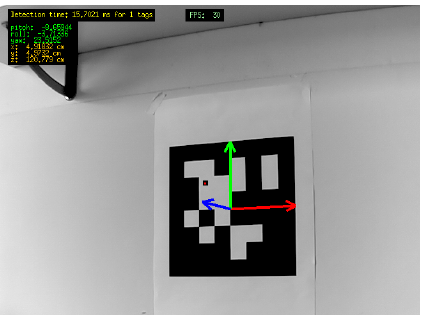
Figure 5. Detection and tracking process: the marker reference frame is shown in red, green and blue for x , y and z axes, respectively. The computer vision algorithm runs on Raspberry PI with a frequency rate of 30 Hz and provides the marker attitude and position in the lens